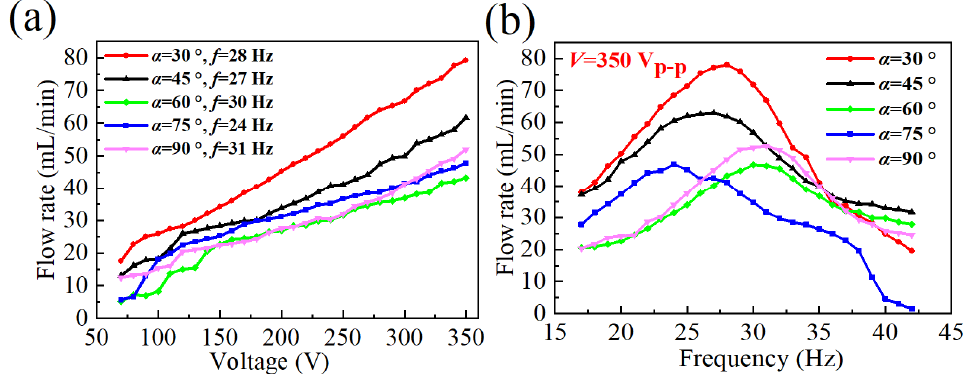
Figure 10. The trend of flow rate with the angle of the Tesla valve at different voltages and frequencies: ( a ) the voltage–flow curve; ( b ) the frequency–flow curve.